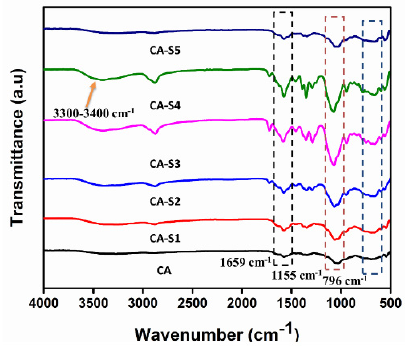
Figure 1. FTIR spectra of the cellulose acetate (CA), CA-S1, CA-S2, CA-S3, CA-S4, and CA-S5 membranes.